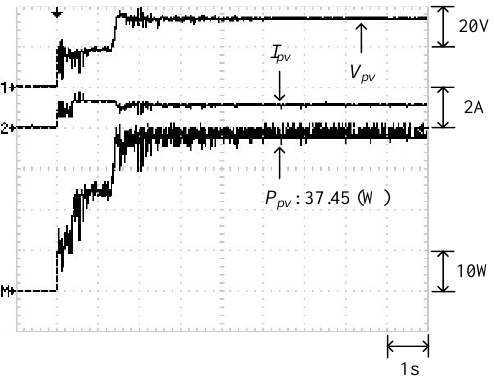
Figure 13. Maximum power point of Case 2 determined through the conventional PSO algorithm.